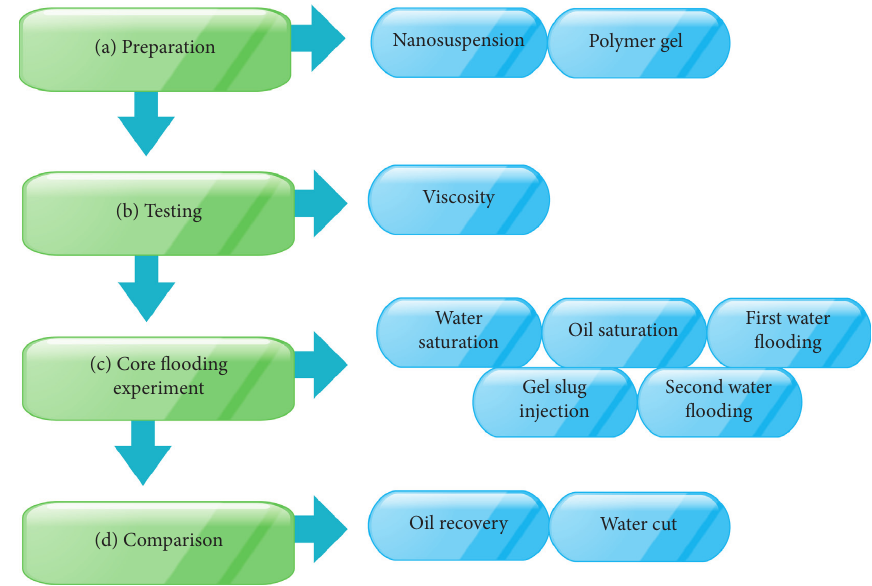
Figure 1: Work flow chart of current